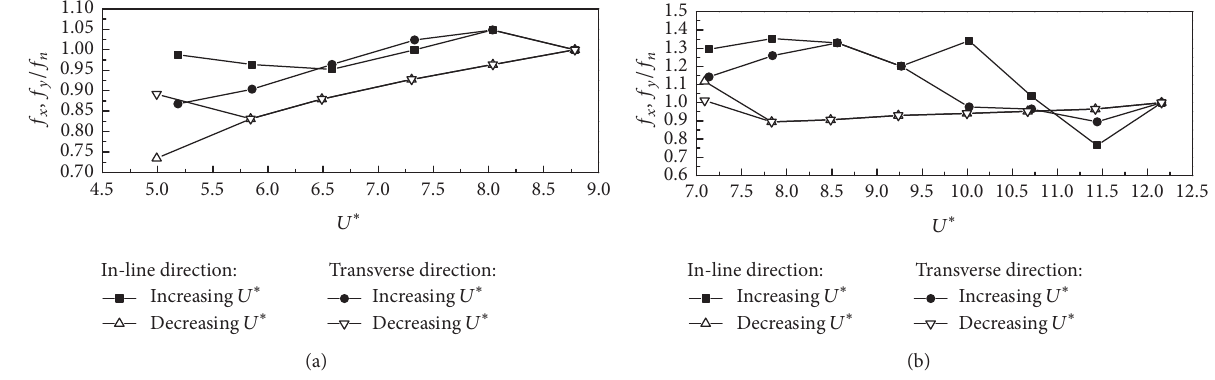
Figure 12: Response frequency versus flow velocity. (a) Aluminum tube and (b) stainless steel